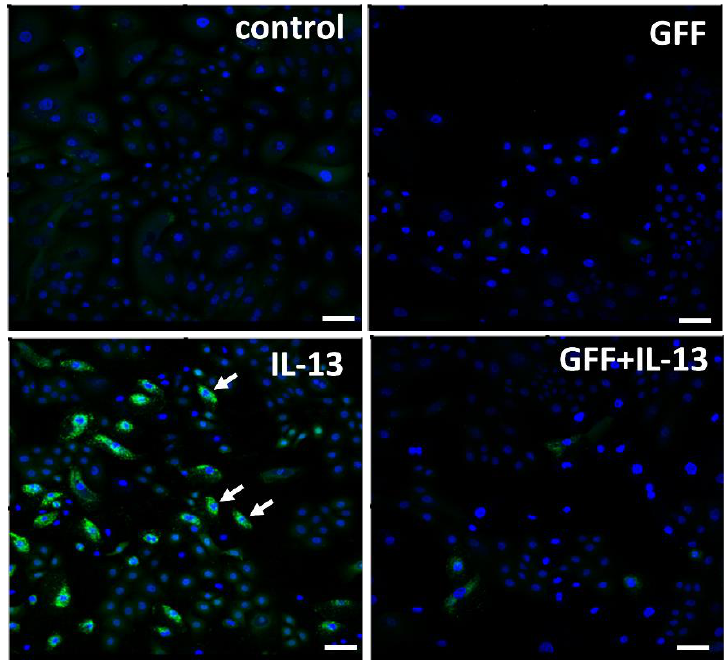
Figure 4. Immunofluorescence staining of ROS (green fluorescence) in human keratinocytes. Nuclei were stained with DAPI. ROS production is minimized in nonstimulated control keratinocytes. IL-13 induces significant ROS production (arrow), which is ameliorated in the presence of GFF. Bar; 25 μm. DAPI: 4′,6 -diamidino-2-phenylindole. ROS: reactive oxygen species. GFF: Galactomyces ferment filtrate.